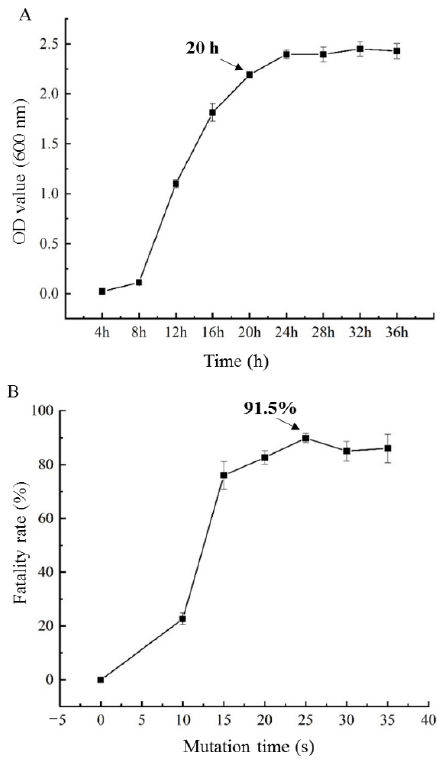
Figure 1. The growth curve ( A ) and the mortality rate treated by atmospheric and room tempera ‐ ture plasma (ARTP) ( B ) of S. paucimobilis ATCC 31461. The arrow in ( A ) indicates the optimal cul ‐ ture time point for ARTP mutation.